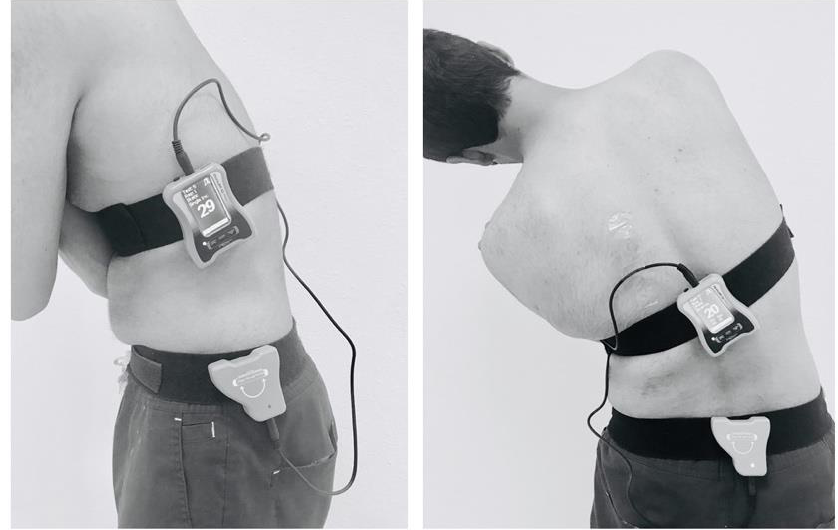
Figure 1. Assessment of lumbar joint position sense using a digital inclinometer.